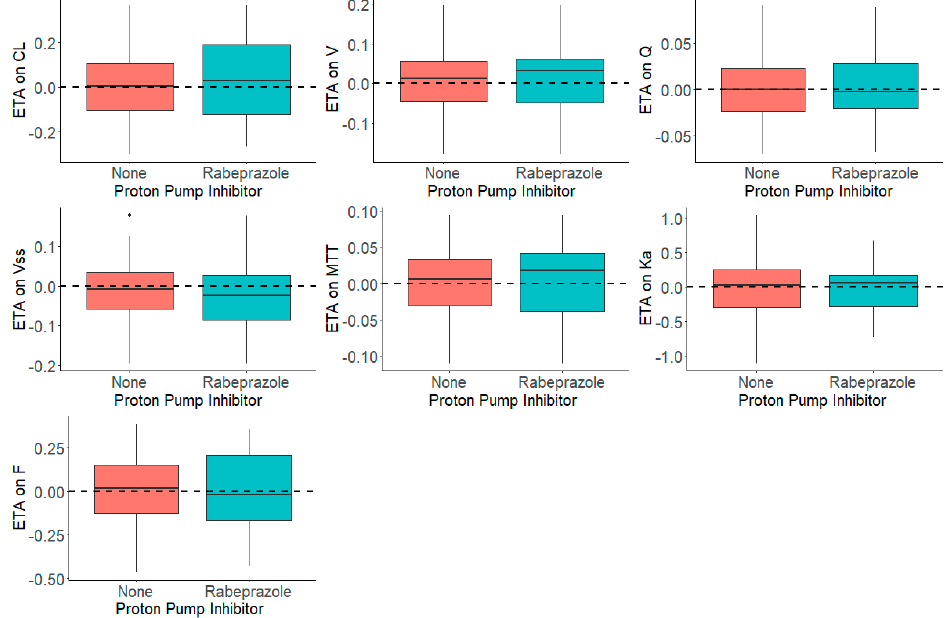
Figure 3. Distribution of η s (ETAs) by the Presence and Absence of Proton Pump Inhibitor, Rabeprazole, in the Dacomitinib Base Model.